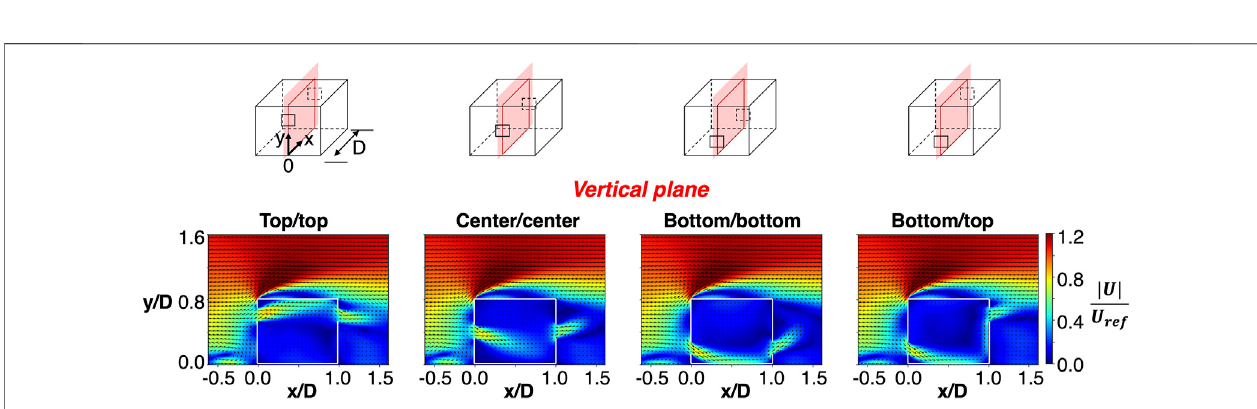
FIGURE 5 | Velocity magnitude and direction on the vertical center-plane of the building in four ventilation con fi gurations with different inlet and outlet locations.